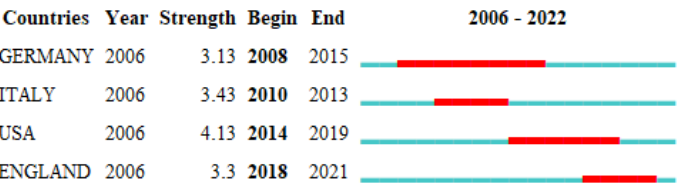
Figure 8. Citation burst history of countries in the timespan ranging from 2006 to 2022. Germany has the longest citation burst, whereas USA has the strongest citation burst.